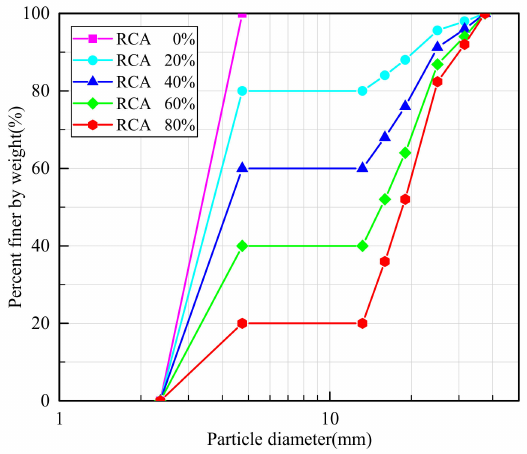
Figure 5. Particle size distributions of the numerical samples with different RCA